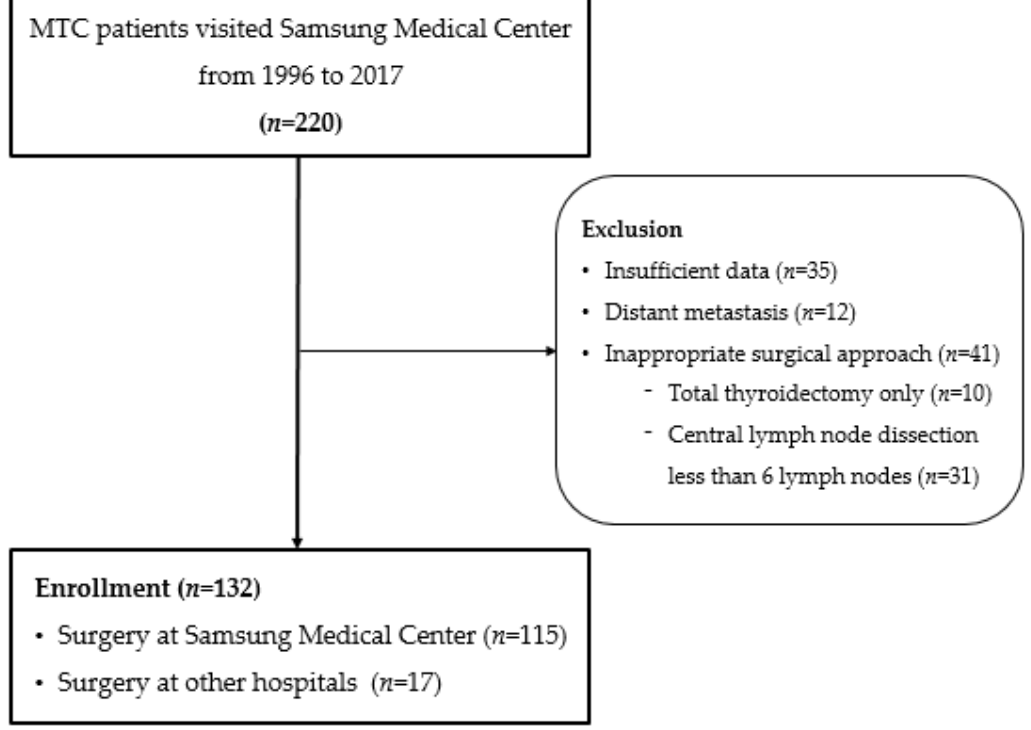
Figure 1. Flow chart showing sample selection.